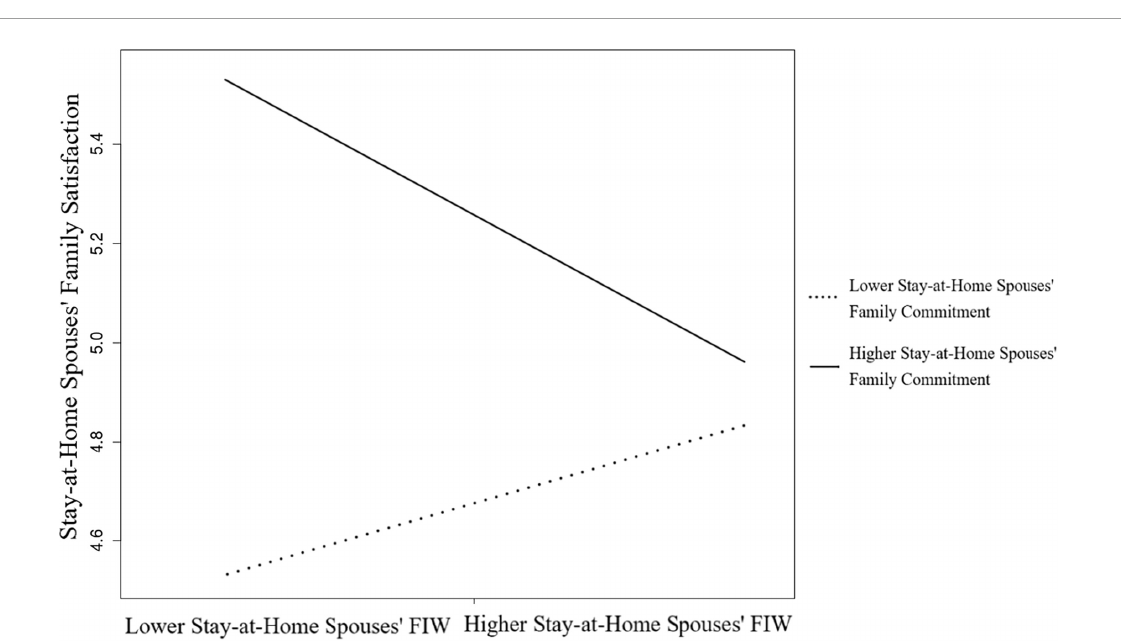
resources. This finding reflects the concept of conjugal interdependence in Lindemann’s (2017) qualitative study, although we do not know how the commuters in our sample committed to their family tasks. However, the commuters might engage in parenting responsibilities